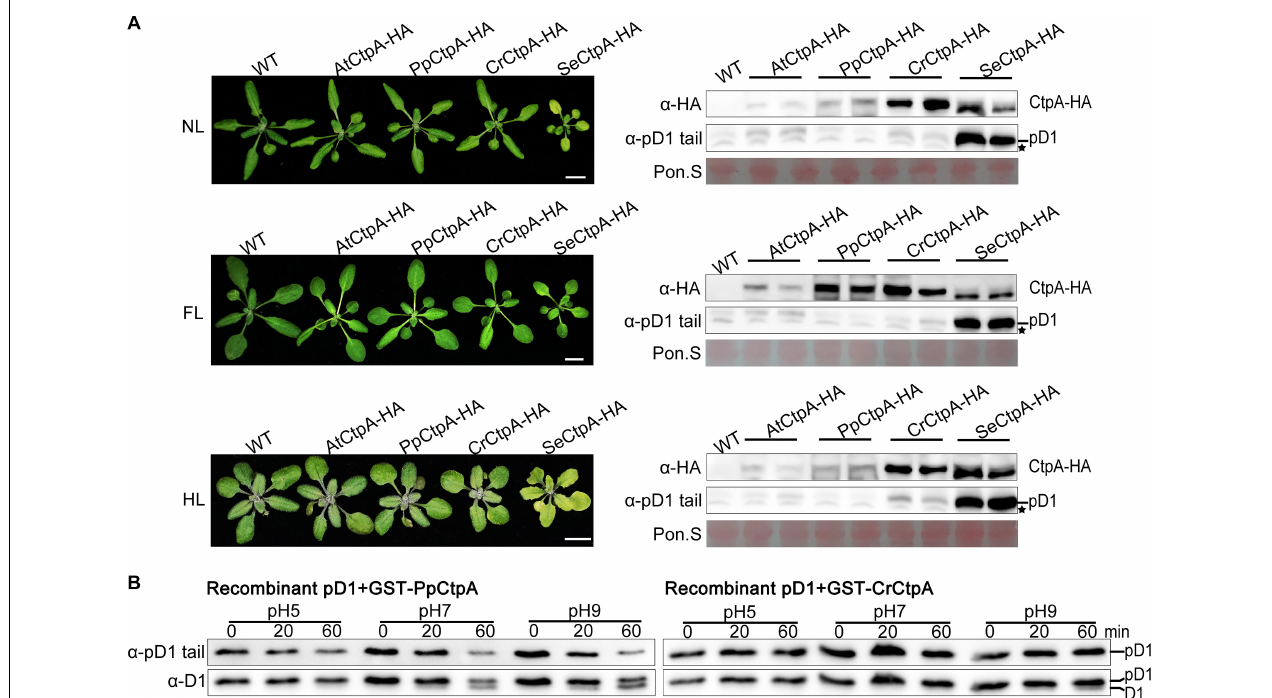
FIGURE 4 | Protease activity of CtpA for AtpD1 processing from four oxygenic photosynthetic organisms. (A) Characterizations of the phenotypes (left) and pD1 processing status (right) in transgenic atctpa plants expressing AtCtpA-HA , PpCtpA-HA , CrCtpA-HA , and SeCtpA-HA under different light conditions. Plants were gown in soil under continuous light as follows: NL, normal light (80 µ mol/s/m 2 ) for 3 weeks; FL, normal light for 1 week, then fluctuating light for 2 weeks (the light intensity changes are shown in Supplementary Figure 3A ); HL, normal light for 2 weeks and then high light (350 µ mol/s/m 2 ) for 1 week. Scale bars denote 1 cm. The pD1 processing in these transgenic plants was assessed by immunoblotting with α -HA (for ectopic expressed CtpA-HAs ) and α -pD1 tail (for native pD1). Two plants were examined for each transgenic line. The filters stained with Ponceau S (Pon. S) were used as loading controls. Asterisks indicate non-specific bands. (B) In vitro protease activities of the PpCtpA and CrCtpA were tested with recombinant AtpD1 substrate. Recombinant AtpD1 was a fusion of GST with the C-terminal 50 aa fragment of Arabidopsis thaliana pD1. Proteolytic reactions were performed in pH 5.0, 7.0, and 9.0, respectively, stopped at the time points of 0, 5, 10, 20, and 60 min, and examined for the pD1 processing statuses by immunoblot against α -pD1 tail (for pD1) and α -D1 (for D1 and pD1) antibodies.